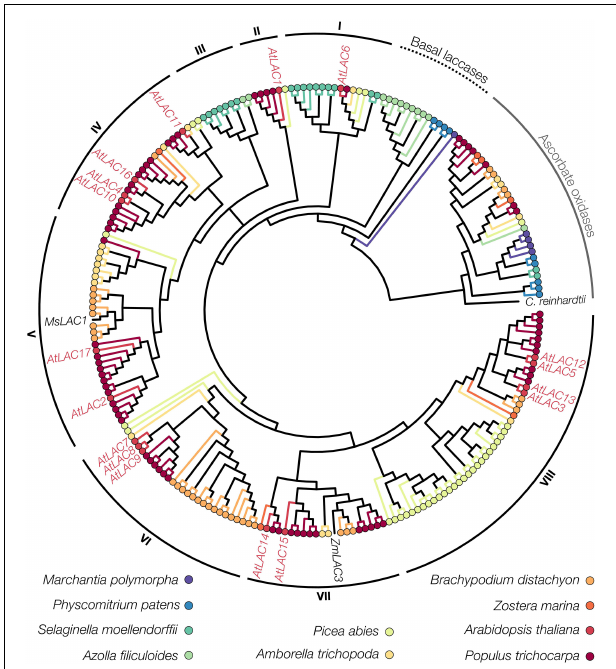
FIGURE 5 | Phylogenetic analysis of LAC homologs. Bayesian phylogeny of high-confidence LAC homologs from 10 species and ascorbate oxidases as the outgroup. The A. thaliana paralogs can be grouped into eight clades which broadly correspond to previous results (Turlapati et al., 2011; Zhao et al., 2013), except for composition and position of clades I and II, and the occurrence of clade III, which have not been described before. Note that the only C. reinhardtii sequence is closer related to ascorbate oxidases than LACs, while no sequence from V. carteri or C. braunii passed the motif-based sequence